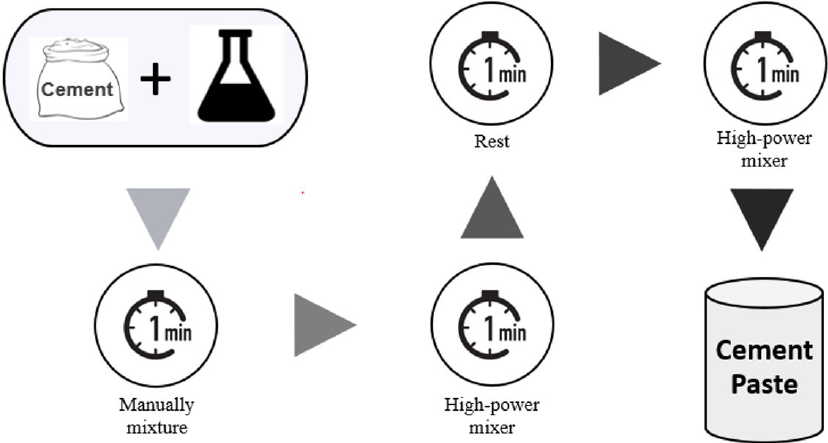
Figure 4. Cement pastes mixing